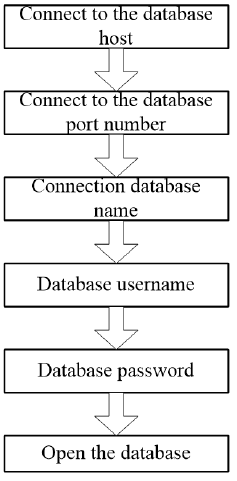
Fig. 6 QT connection to MySQL database